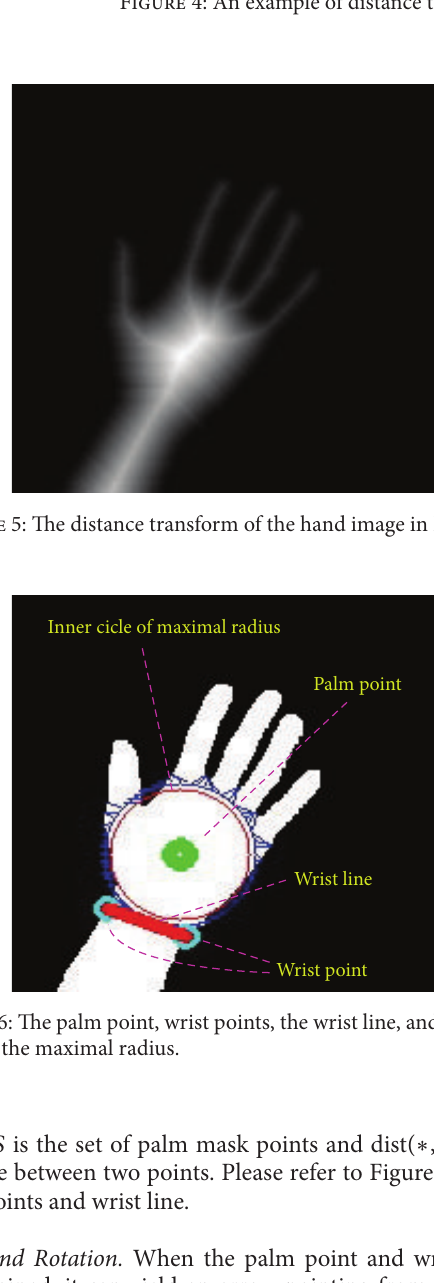
Figure 4: An example of distance transform: (a) is a binary image; (b) is the distance transform.